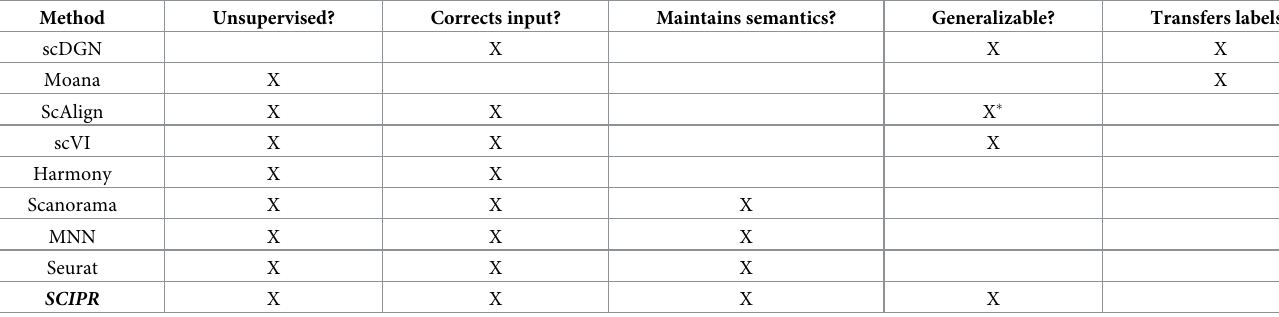
Table 1. Comparison of features and properties of various scRNA-seq alignment